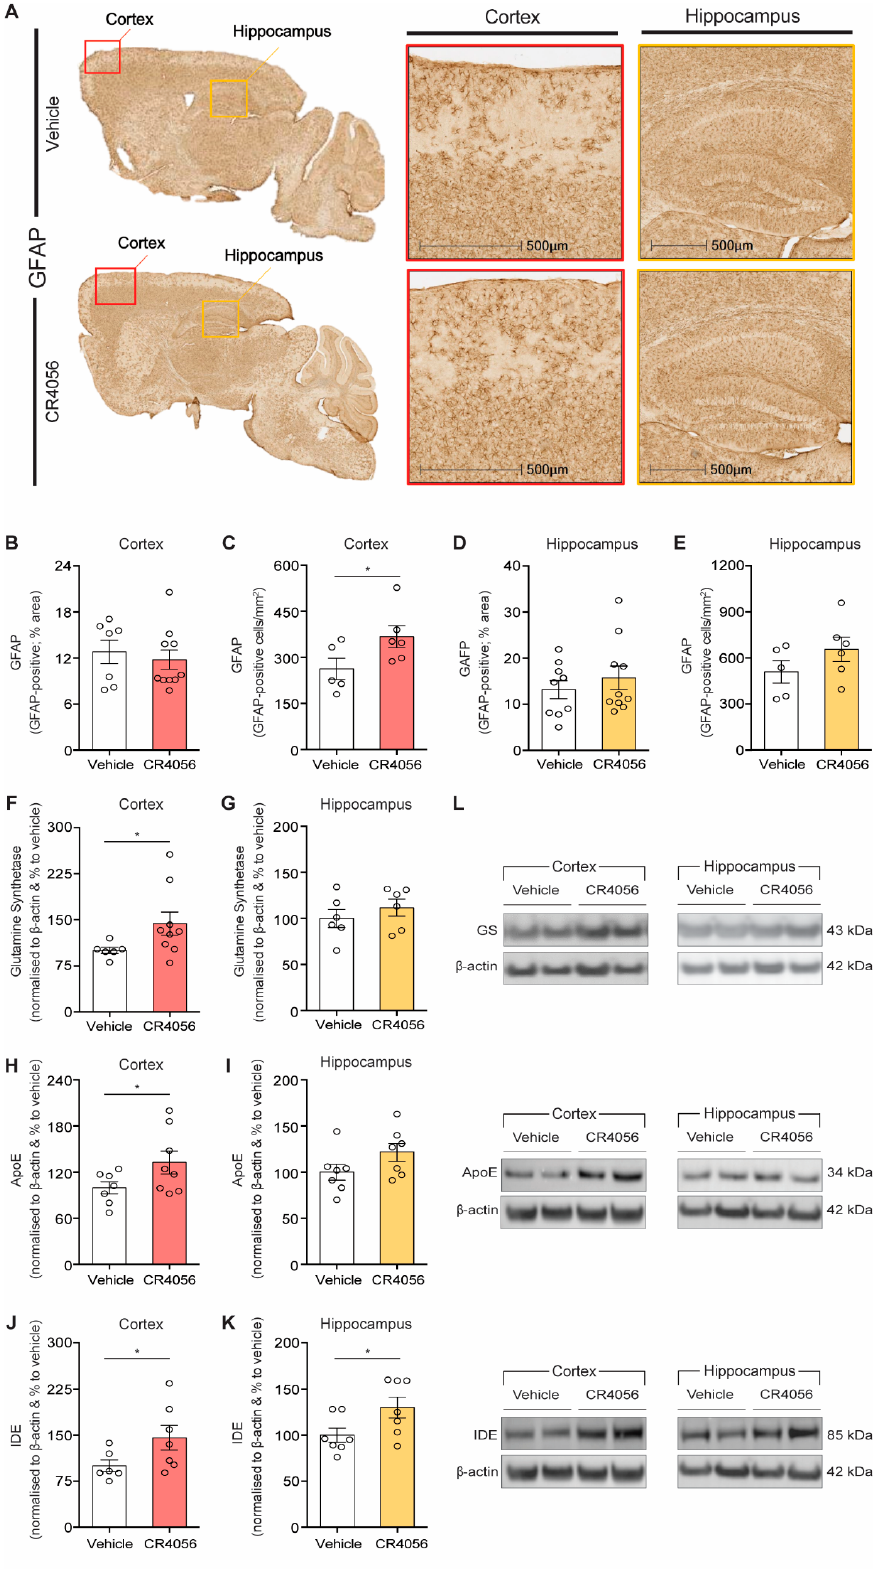
Figure 4. CR4056 increases astrocytic and A β clearance markers in 5xFAD mice. ( A ) Representative images of GFAP staining in sections of 6-month-old 5xFAD mice after treatment with vehicle